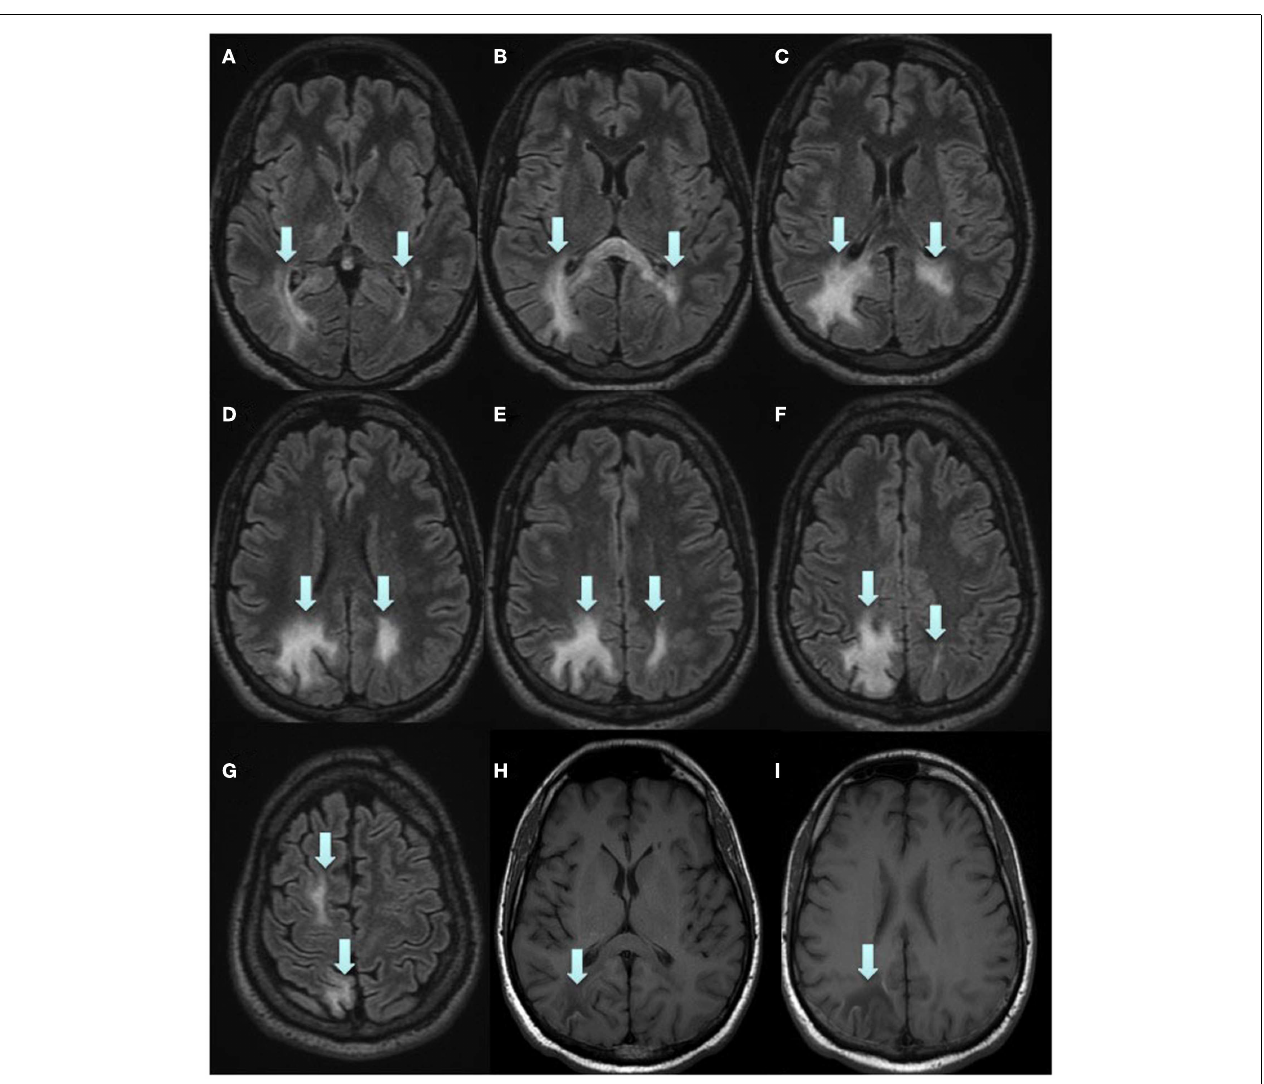
FIGURE 4 | Final, stable status, 7months after PML diagnosis. 3D Flair (A–G) andT1w SE (H,I) . (H,I) Show laminar necrosis in part of the initial lesion. Arrows in (A–G) indicate the PML lesions and in (H,I) the laminar